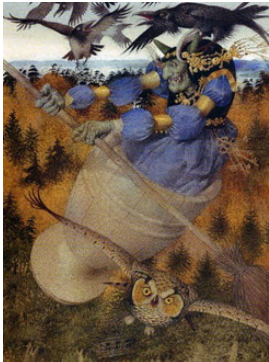
Figure 4. Baba Yaga. Illustration for the children’s book. The artist is G. Spi -